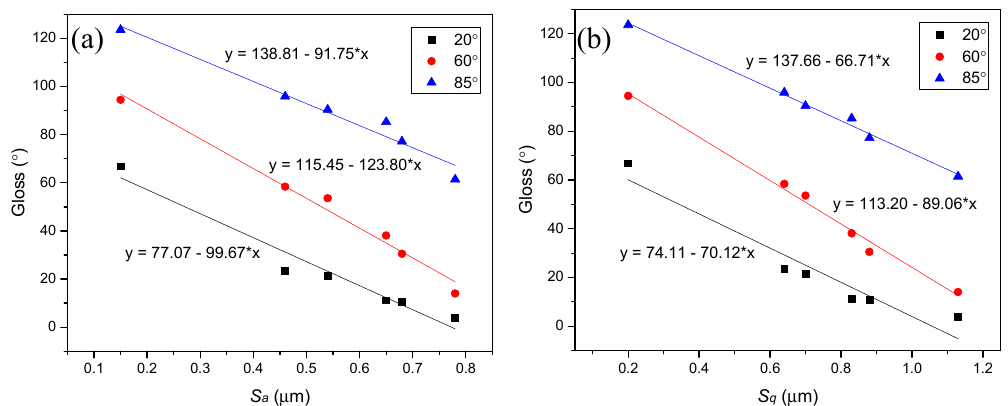
Figure 7. Gloss as a function of surface roughness ( a ) S a and ( b ) S q calculated from 5000 µ m × 5000 µ m images.